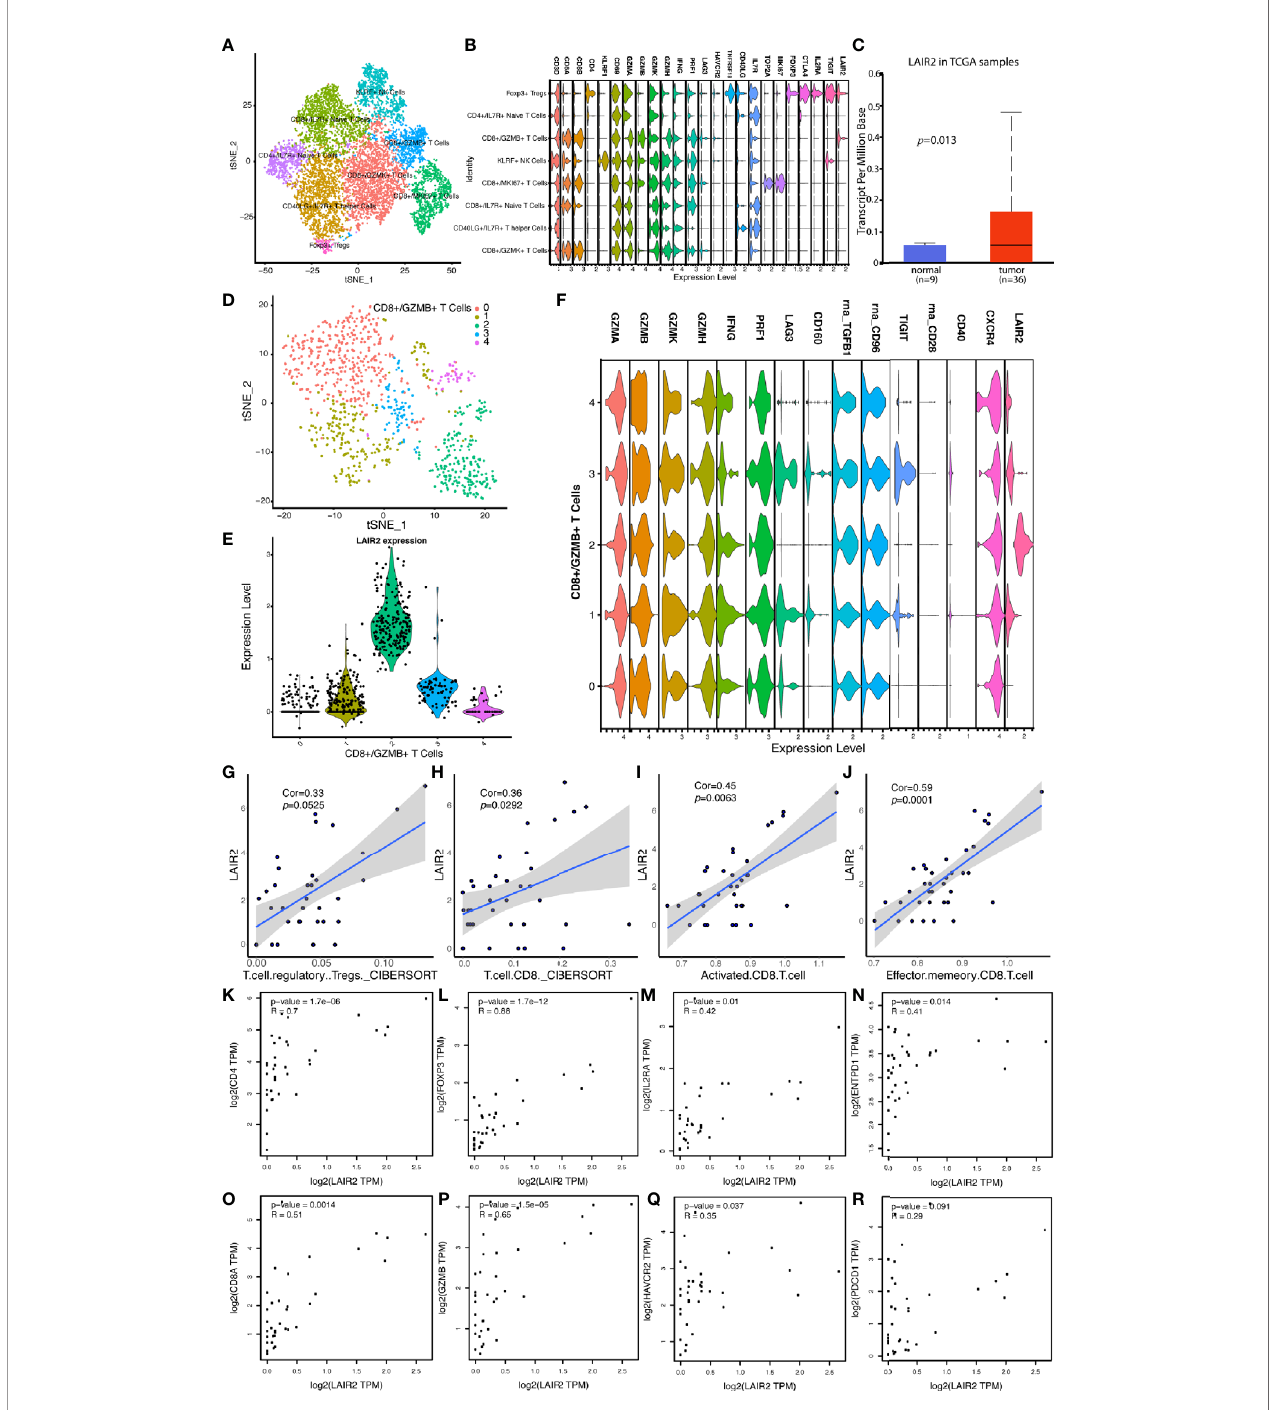
FIGURE 6 | LAIR2 Was Highly Expressed by Regulatory T Cells and CD8+/GZMB+ T Cell Subset. (A) TSNE reduction for demonstration of NK and T cell atlas. (B) Markers for sub T and NK cell populations. (C) LAIR2 expression levels between CCA tumor and normal tissues in TCGA database. (D) Further cluster of CD8 +/GZMB+ T cells. (E) LAIR2 expression in further clustered CD8+/GZMB+ T cell sub-populations. (F) Functional markers ’ expression levels between further clustered CD8+/GZMB+ T cell sub-populations. (G – J) Correlation between LAIR2 expression and scores for regulatory T cell and CD8+ T cell calculated by CIBERSORT or ssGSEA method. (K – N) Correlation between LAIR2 and Treg markers [CD4, FOXP3, IL2RA (CD25), and ENTPD1 (CD39)] in CHOL bulk sequencing data from GEPIA database. (O – R) Correlation between CD8A, GZMB, HAVCR2 (TIM3), PDCD1 (PD1), and LAIR2 in CHOL bulk sequencing